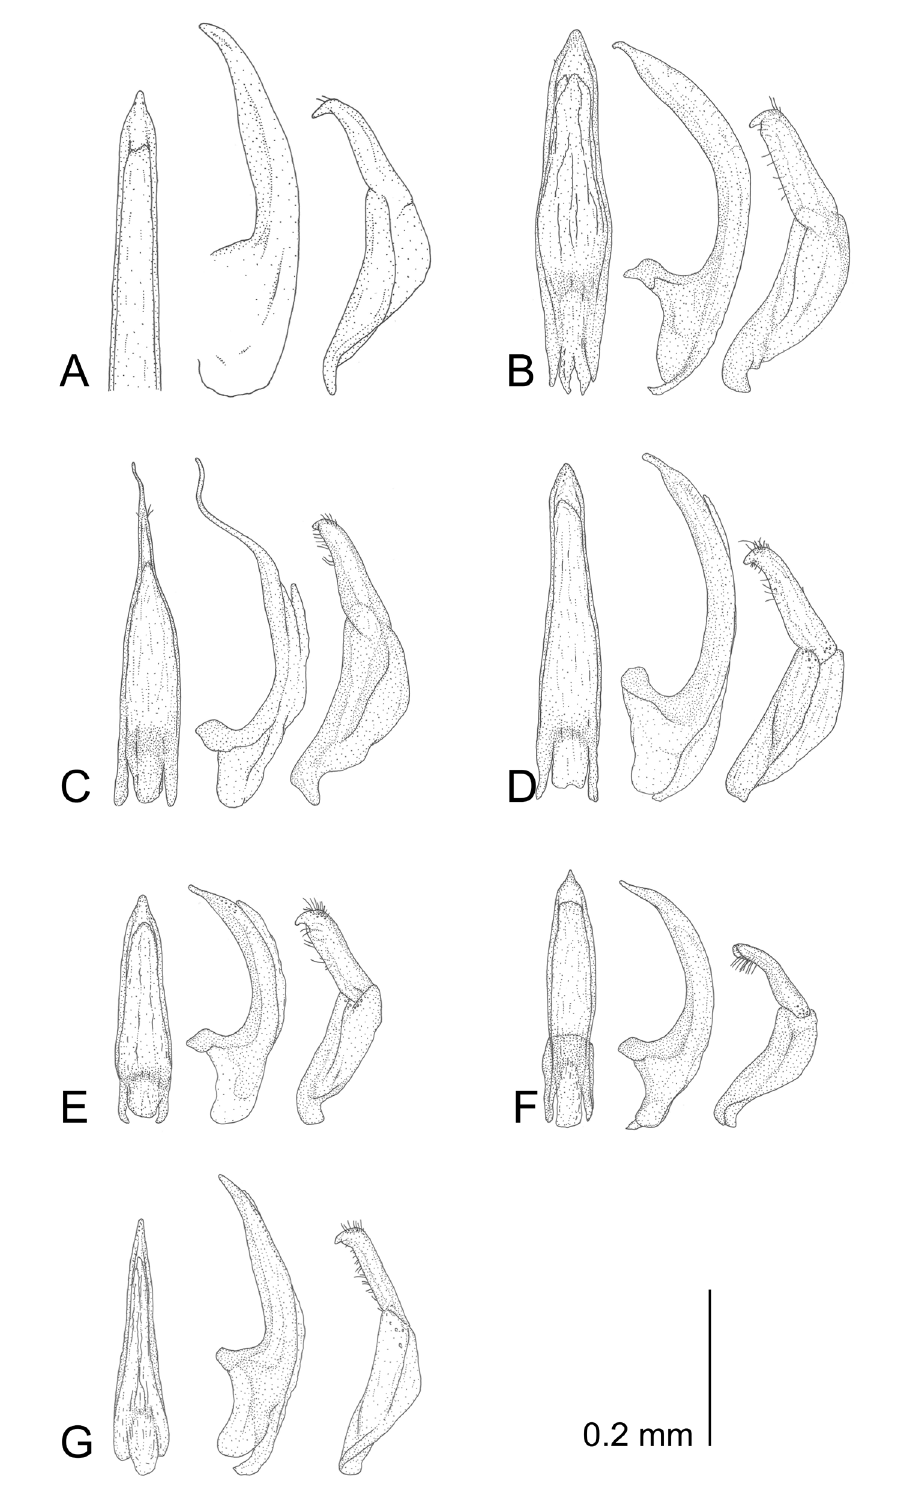
Fig. 3. Male genitalia of the Malagasy species of Bidessus Sharp, 1882. For each subpanel from left to right penis in dorsal view, penis in lateral view and paramere in lateral view. A . B . apicidens Biström & Sanfilippo, 1986. B . B. cf. ceratus Guignot, 1941. C . B. anjozorobe sp. nov. D . B. cf. nero Gschwendtner, 1933. E . B. nesioticus Guignot, 1956. F . B. perexiguus Kolbe, 1883. G . B. longistriga Régimbart,